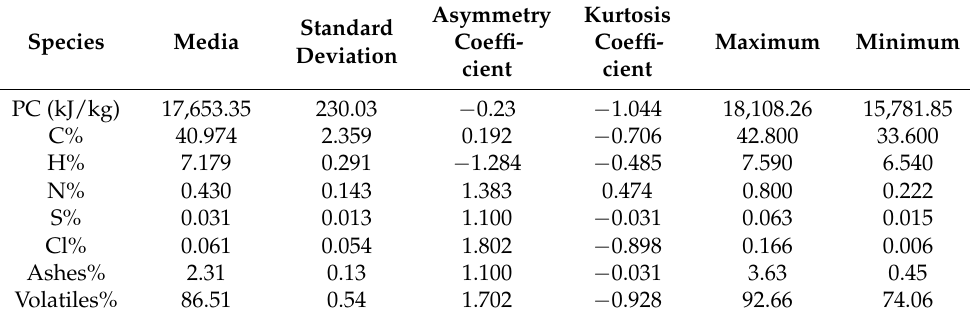
Table 8. Characterization of citrus dry woody biomass.